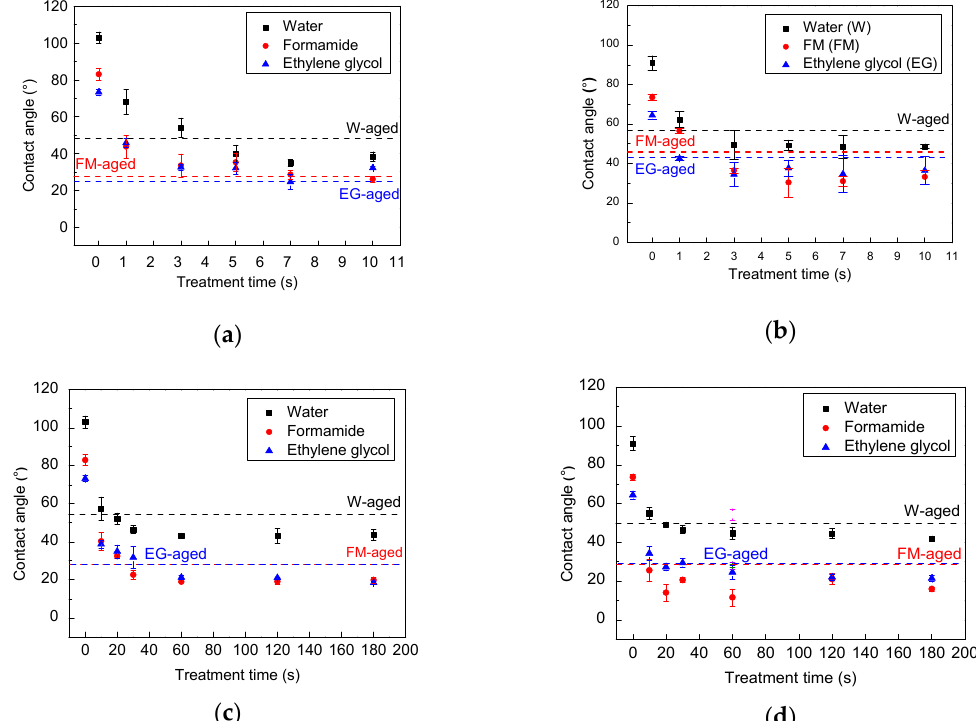
Figure 6. Contact angle of: ( a )—corona treated HDPE, ( b )—corona treated HDPE / EG, ( c )—RF treated HDPE, and ( d )—RF treated HDPE / EG. Dashed lines represent plasma treated samples for 7 s and aged 2 months.